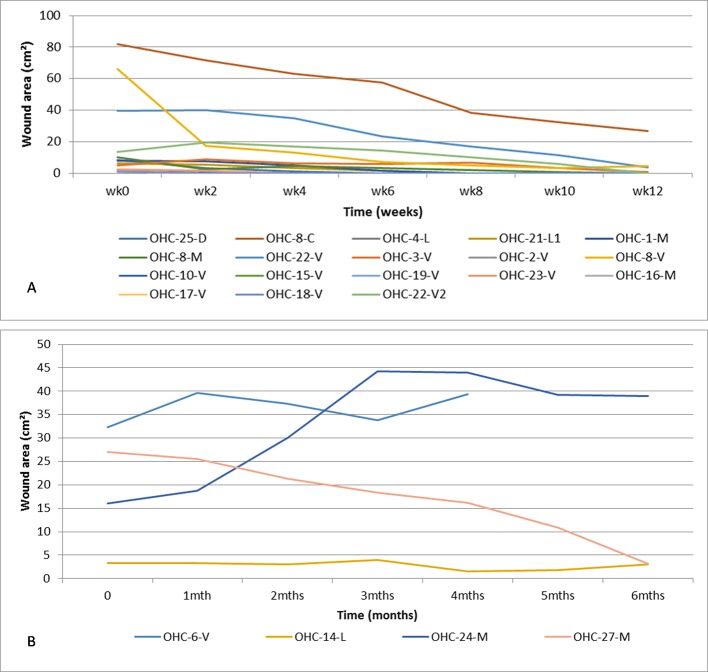
Development of IS2404 PCR positive ulcers measured by change in wound area over time at the PHC center (the patient code “OHC” refers to the patient numbering at the PHC center in Obom) A acute ulcers which healed within the observations period B chronic non healing ulcers.